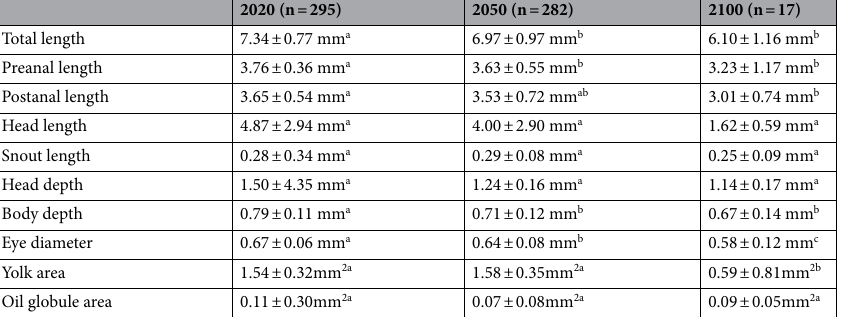
Table 2. Mean and standard deviations of morphometric data for Lingcod larvae samples from year 2020, year 2050, and year 2100 treatments. Count (n =) represents the number of larvae measured using ImageJ for each treatment, not the total hatch number. Treatments with different letters for each response variable were significantly different (nested mixed model ANOVAs; p <